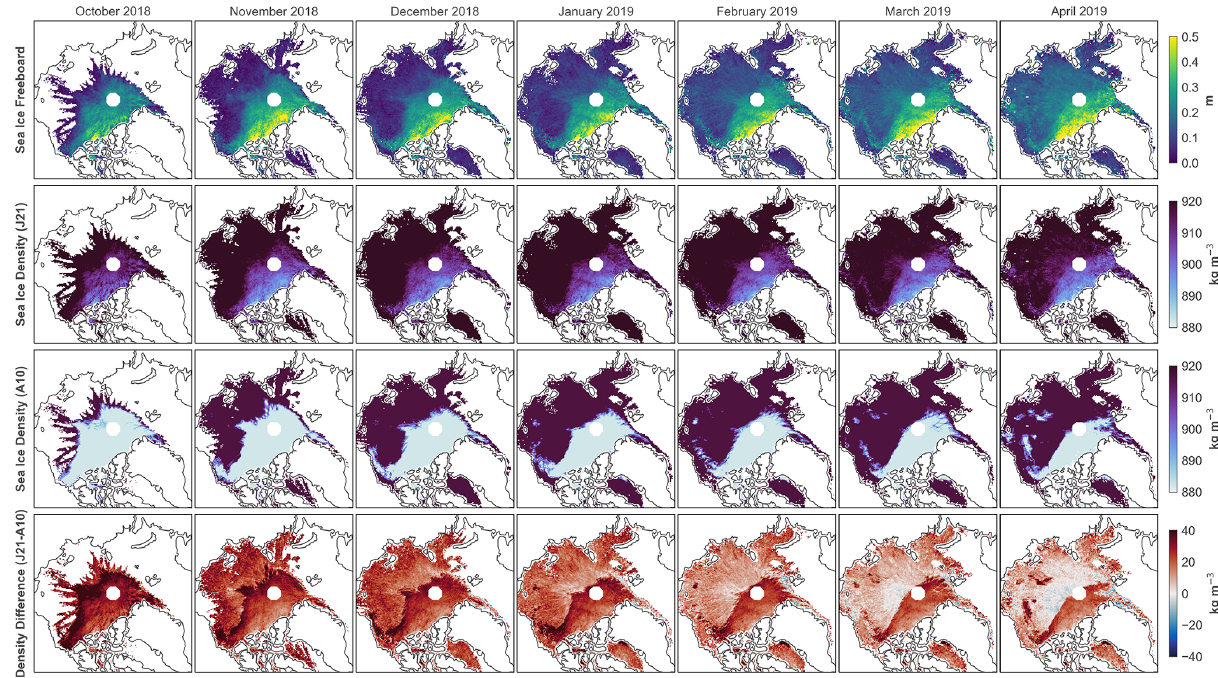
Figure 9. Sea-ice density parameterisation applied to the monthly gridded AWI CryoSat-2 Sea Ice Product (Hendricks and Ricker, 2020) for the winter 2018/2019. The rows show sea-ice freeboard, sea-ice density derived using Eq. (7) (J21), sea-ice density currently used in the product (A10), and the difference between the two (J21 − A10). The columns from left to right show monthly means from October 2018 to April